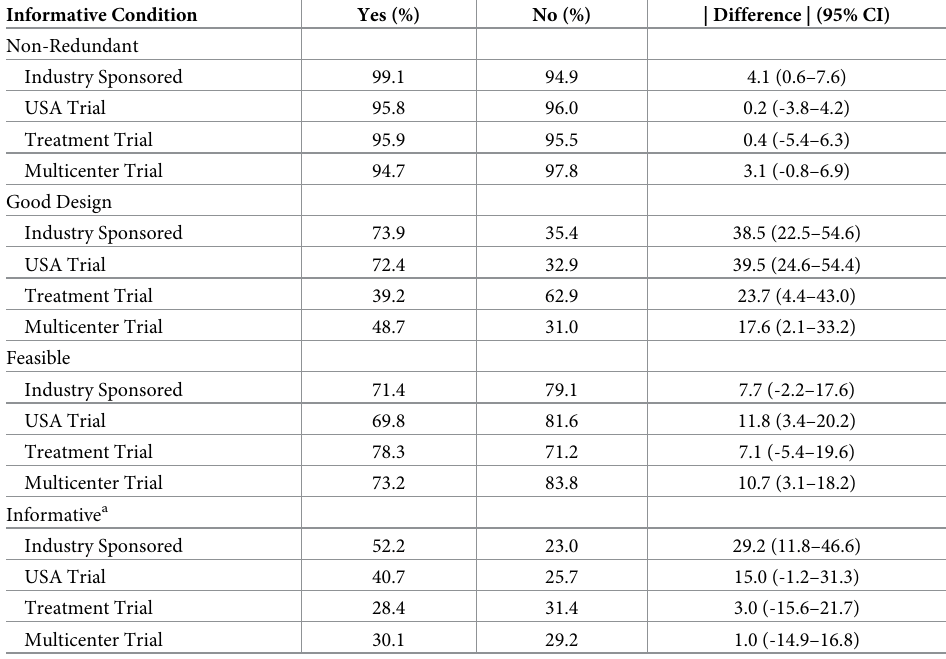
Table 3. Stratified analysis of redundancy, design, trial feasibility and informativeness by sponsor, country loca- tion, trial type, number of trial